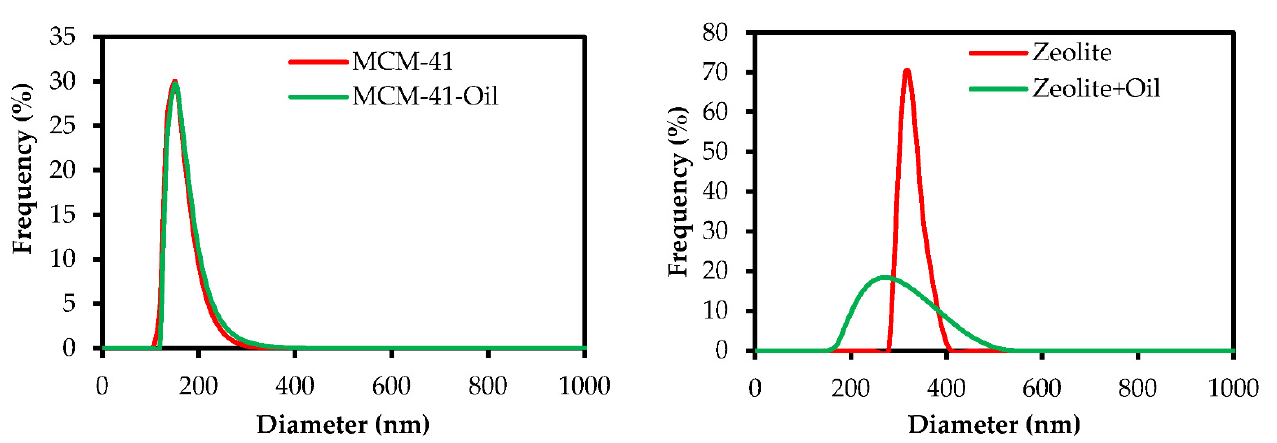
Figure 3. Scanning electron microscopy (SEM) micrographs (( A ): MCM-41; ( B ): MCM-41-essential